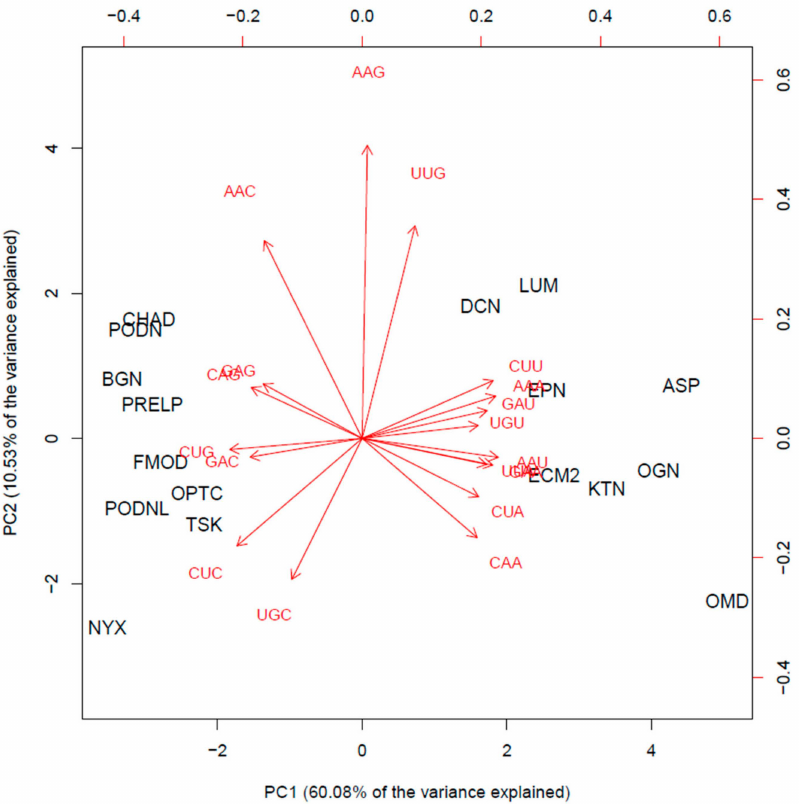
Figure 3. Biplot: scores of the 17 members of the SLRP family (in black) projected on the first two PCs (bottom and left first two PC scores), and red arrows indicate the loading vectors in the space of the codon usage frequency features (top and right axes first two PC loadings). Table 2. Representation of the biased codon usage patterns of the mature mRNA transcripts among Cluster 1 and Cluster 2 of the SLRP family. Over-represented codons are colored in green and marked by a ‘ + ’; under-represented codons are colored in red and marked by a ‘–’. Cluster 1 Cluster